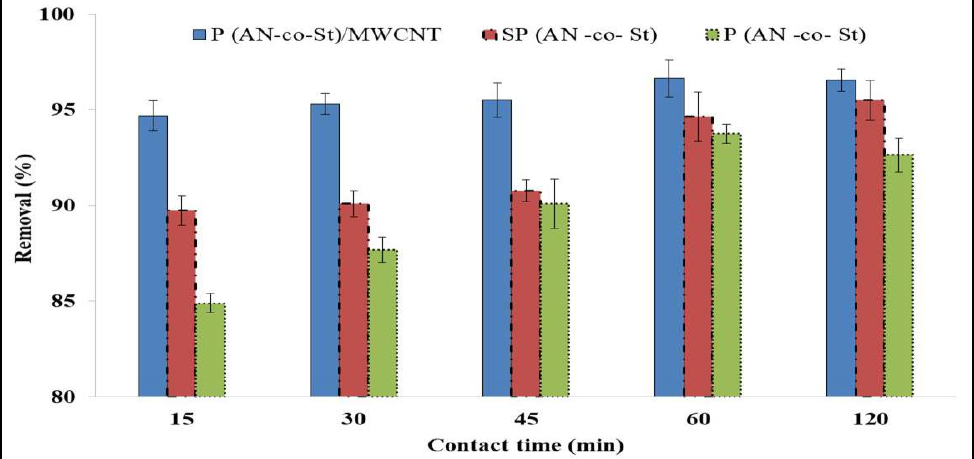
Figure 8. Effect of contact time on the adsorption of MO